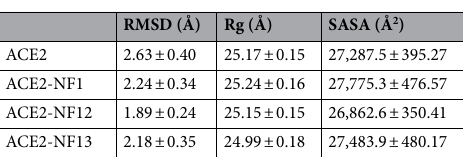
Table 2. Average values of the structural order parameters (RMSD, Rg and